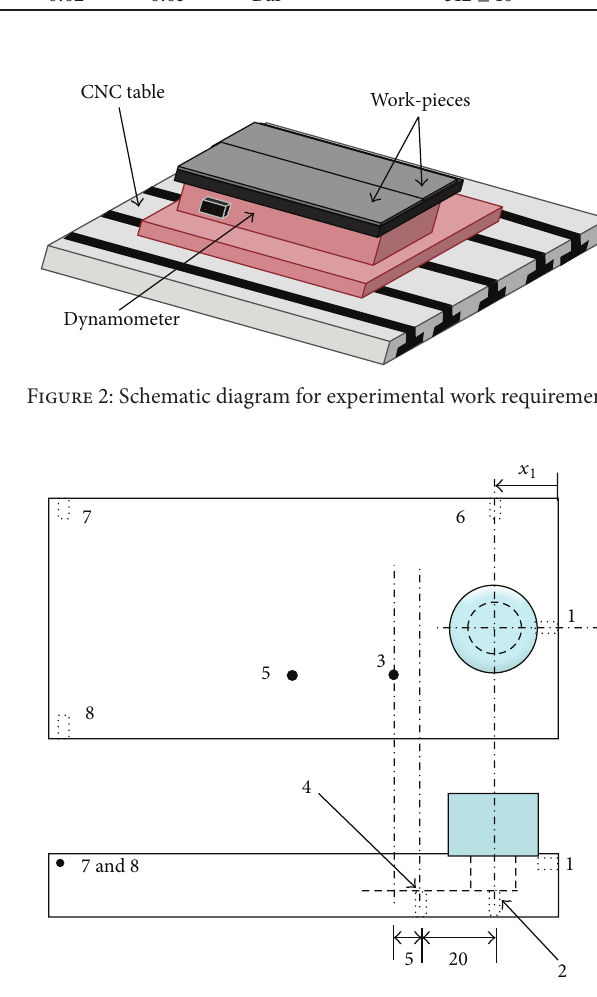
Figure 3: Positions of holes on the plate for thermocouple temper- ature